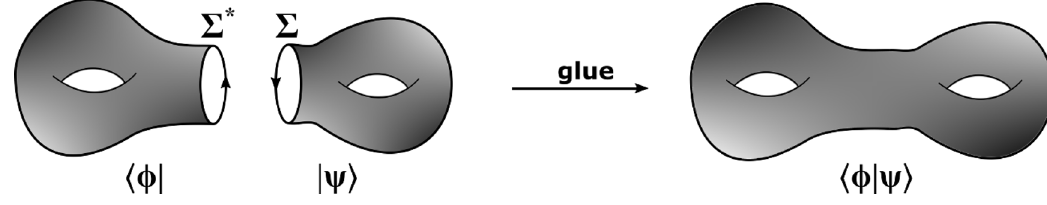
Figure 2. Two manifolds on left with same boundary but opposite orientation. The path integral on these manifolds gives states h φ | ∈ H Σ ∗ and | ψ i ∈ H Σ . The inner product h φ | ψ i will be the partition function of manifold shown in right obtained by gluing the two manifolds along the common boundary.